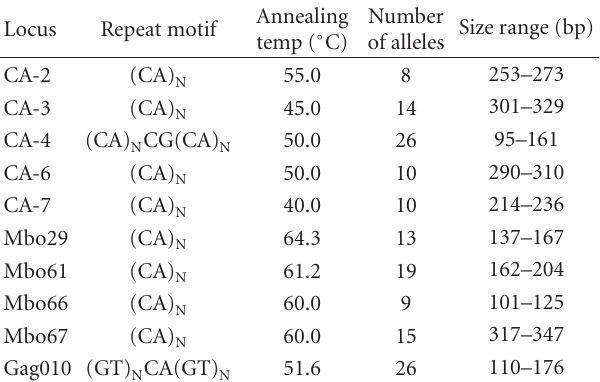
Table 1: Repeat motifs, annealing temperatures, number of alleles per locus, and size range for ten microsatellite